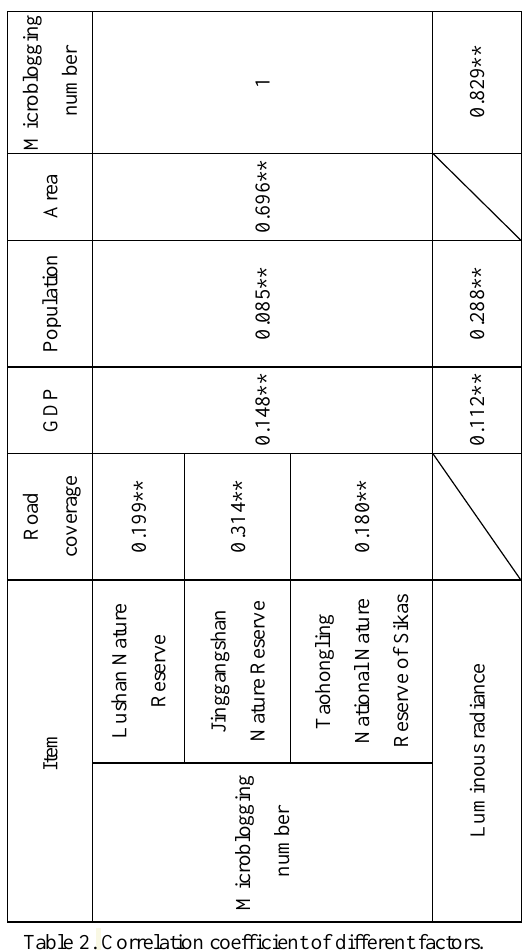
Table 2. Correlation coefficient of different factors . Significance of correlation coefficients is shown as** P < 0.01